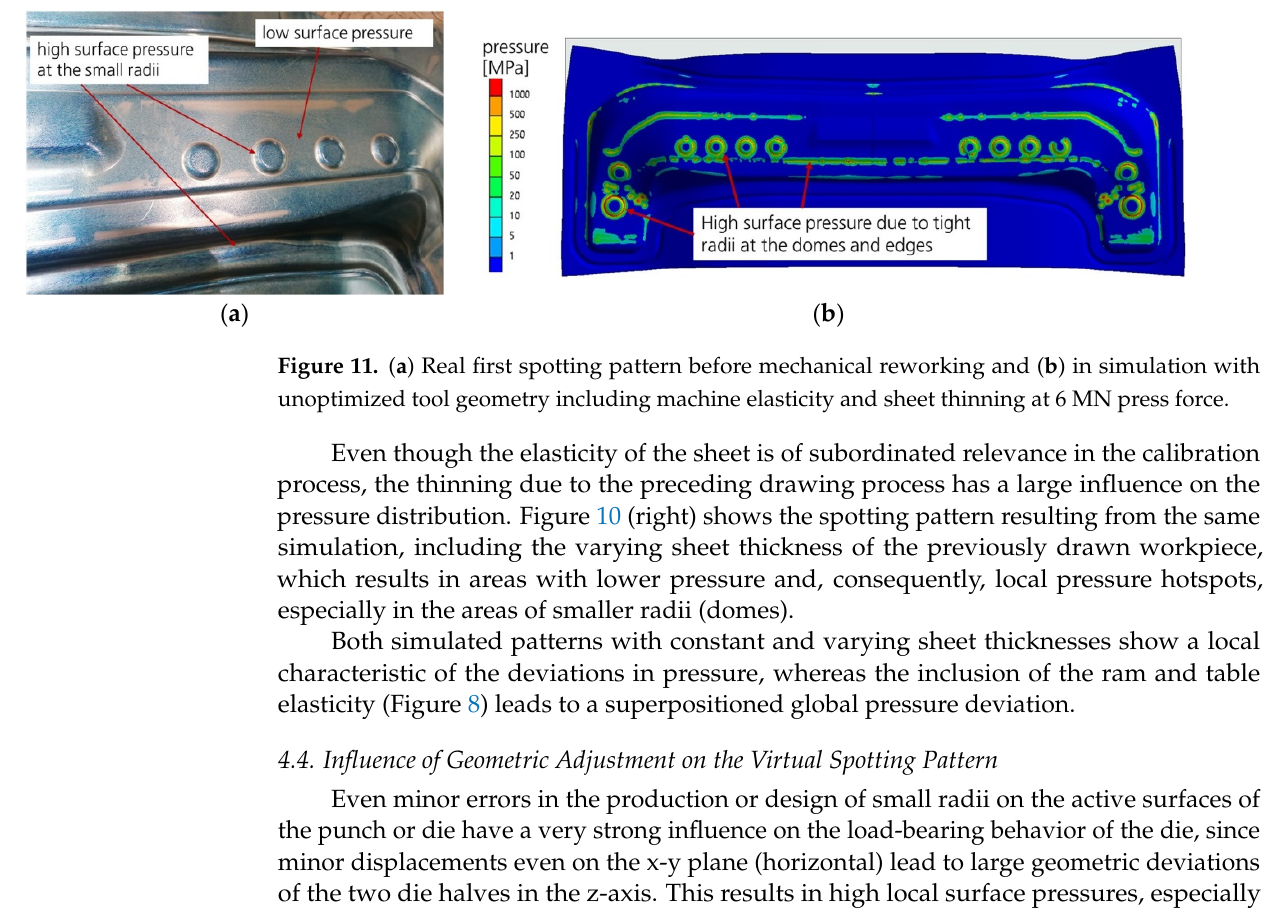
Figure 10. Virtual spotting pattern with 6 MN press force, ideal die geometry, infinite stiffness of the table and ram clamping surface, without sheet thinning ( left ) and with sheet thinning ( right ).